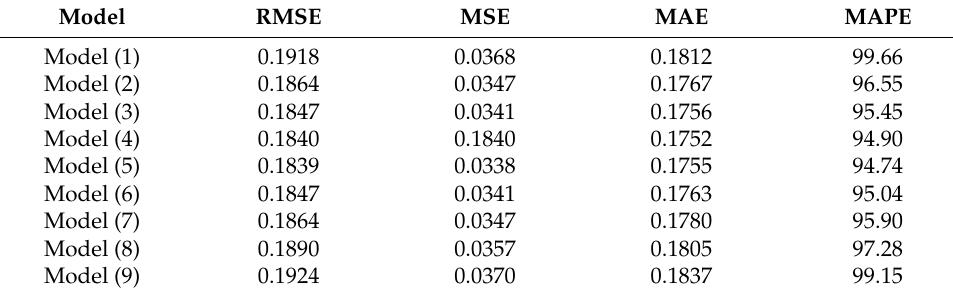
Table 5. Evaluation the level of uncertainty for Gaussian IT2